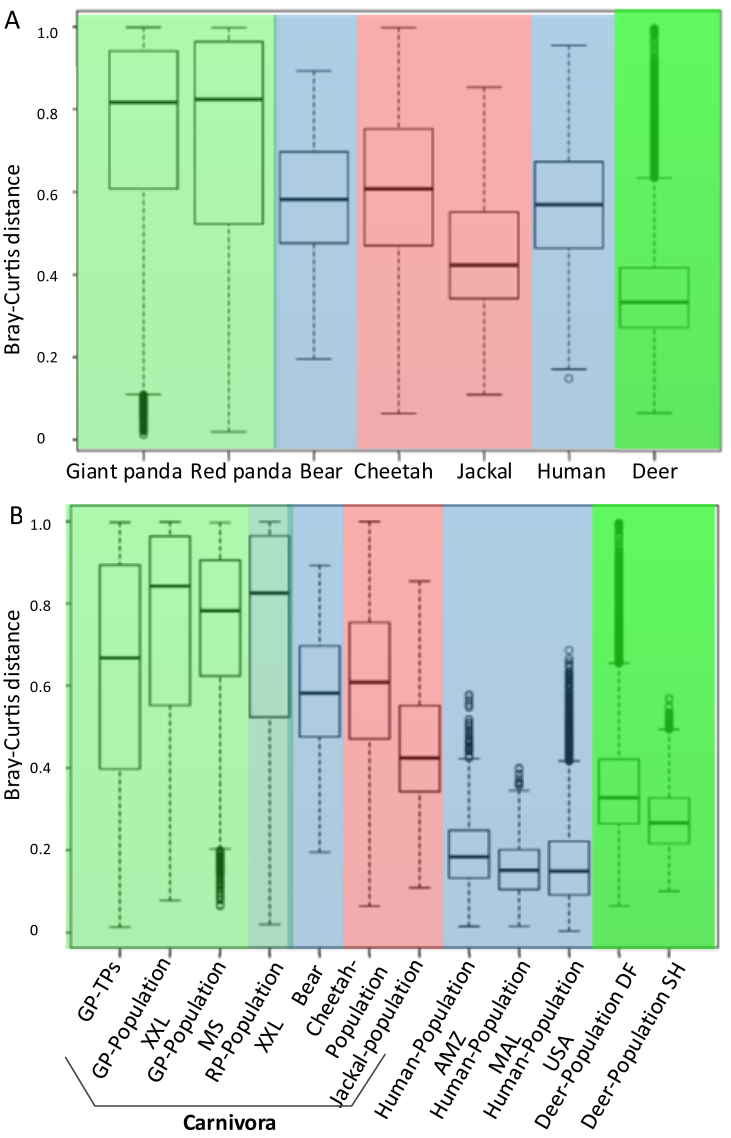
Bray-Curtis dissimilarity using gut microbiome species among the giant panda, red panda, deer, human (Yatsunenko et al., 2012), cheetah (Menke et al., 2014), black-backed jackal (Menke et al., 2014), and black bear (Song et al., 2017). GP, giant panda; RP, red panda; AMZ, human Amazons; MAL, human Malawi. DF, Dafeng Milu Natural Reserve; SH, Shishou Milu Natural Reserve. Bear, black bear from three conservation centers in China.